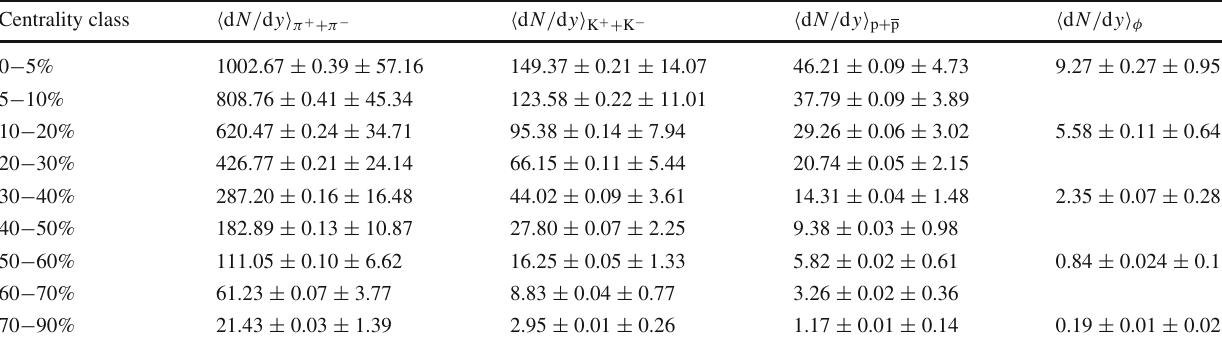
Table 4 (cid:6) d N / d y (cid:7) of pions, kaons, (anti-)protons and φ for different centrality classes as measured at midrapidity in Xe–Xe collisions at 5 . 44 TeV. The uncertainties are reported in the order ± (stat) ± (syst) Centrality